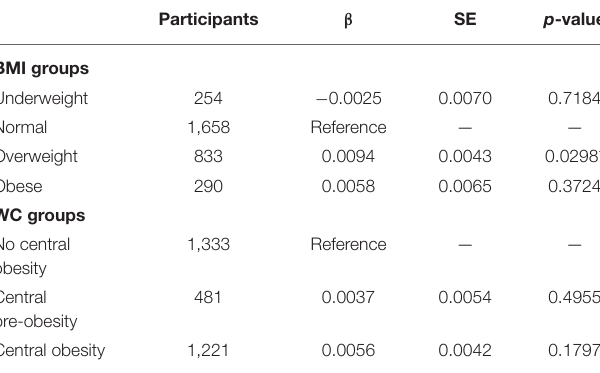
TABLE 4 | The association between global cognitive decline (SD per year) comparing quartiles of baseline BMI and WC. Participants